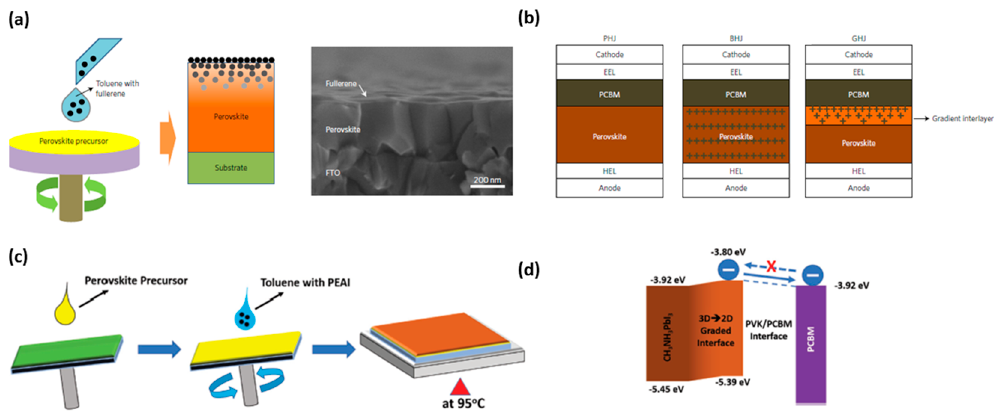
Figure 8. ( a ) A schematic of the method of depositing fullerene molecules at the very top surface of the perovskite along with a cross-sectional SEM image of the dripping-induced perovskite–PCBM stacking. ( b ) Schematic of the p-i-n solar cell depicting the formation of a graded heterojunction, GHJ (perovskite with a gradient distribution of PCBM), in comparison with typical planar (PHJ) and bulk heterojunction (BHJ) devices. Reproduced from Ref. [55] with permission from Nature Publishing Group. ( c ) The schematic of the 3D-2D perovskite deposition. ( d ) Schematic of energy level alignment at the 3D-2D perovskite and PCBM interface. Reproduced from Ref [59] with permission from Wiley- VCH.